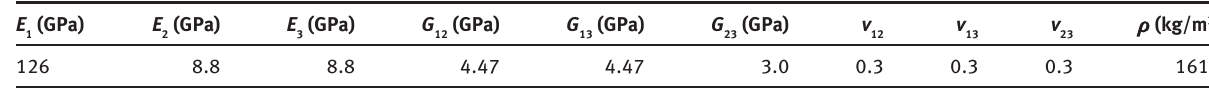
Table 1: Material properties of